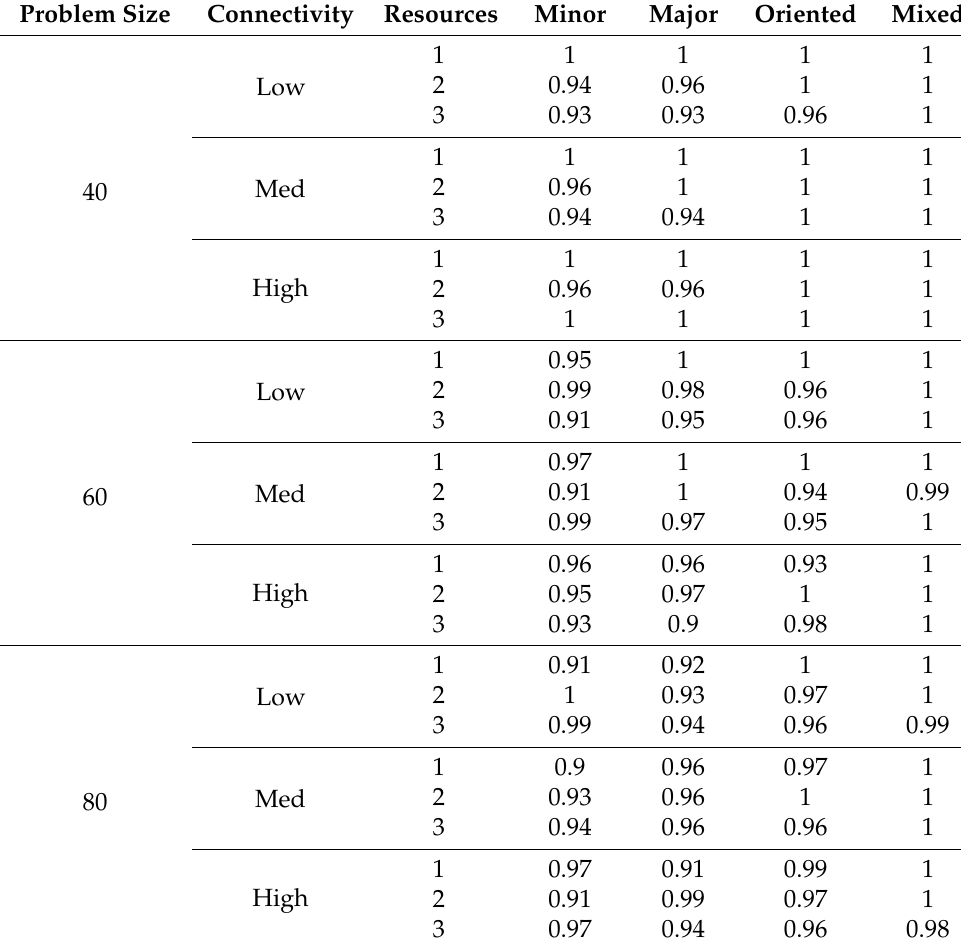
Table 4. Initial results: ratio to optimal best known. Problem Size